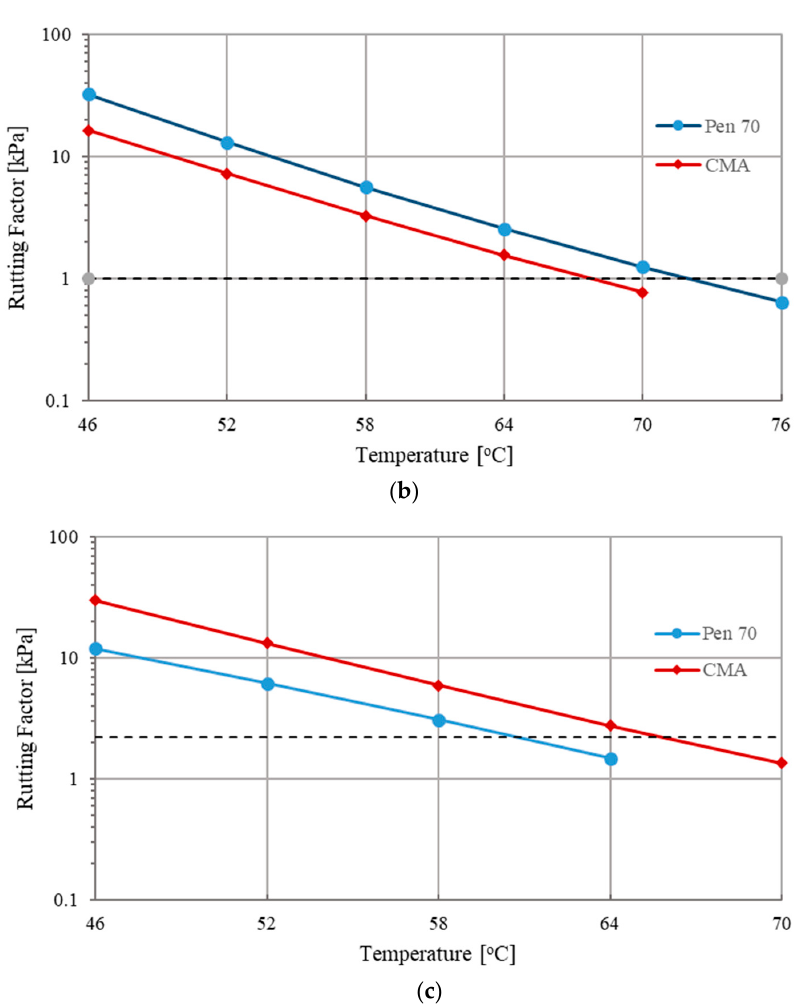
Figure 5. Results of temperature sweep test: ( a ) failure temperature, rutting factor for unaged samples ( b ), and aged samples ( c ).